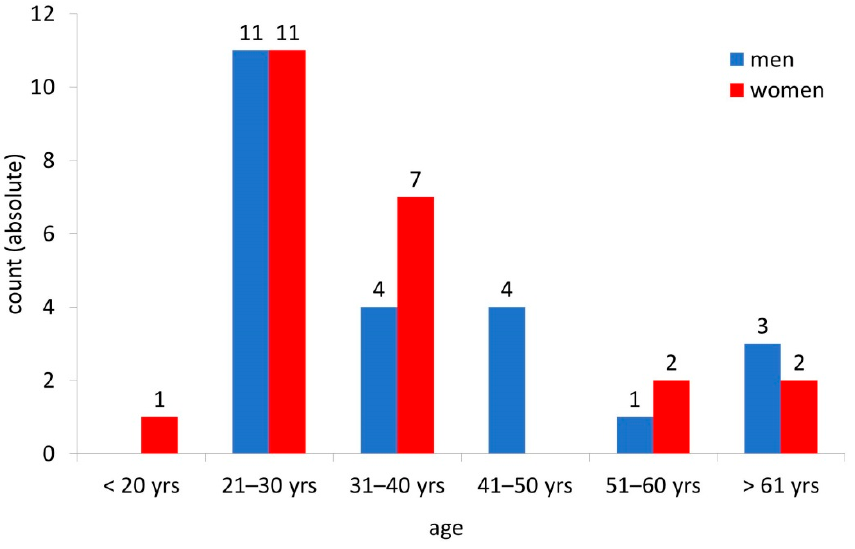
Figure 1. Participant distribution by age and gender.